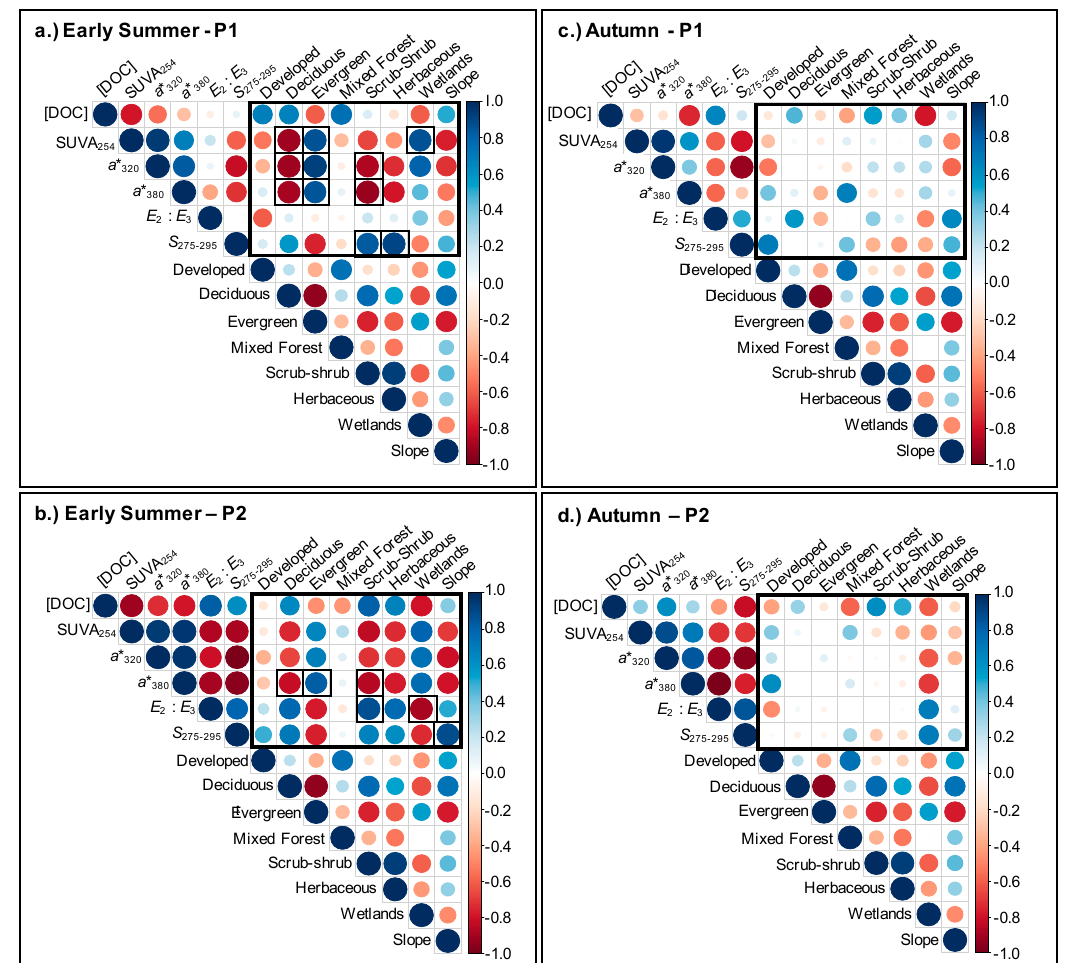
Figure 5. Correlations between the percent change of [DOC], SUVA 254 , a * 320 , a * 380 , E 2 : E 3 , and S 275–295 and land cover (outlined in the larger boxes) during the Early Summer for ( a ) P1 and ( b ) P2 and Autumn ( c ) P1 and ( d ) P2 storm samplings. Bold borders on cells (within the larger boxes) indicate significant relationships ( p < 0.05) between changes in DOC metrics and land cover. Larger circles indicate stronger correlations, red circles indicate negative correlations and blue circles indicate positive correlations.